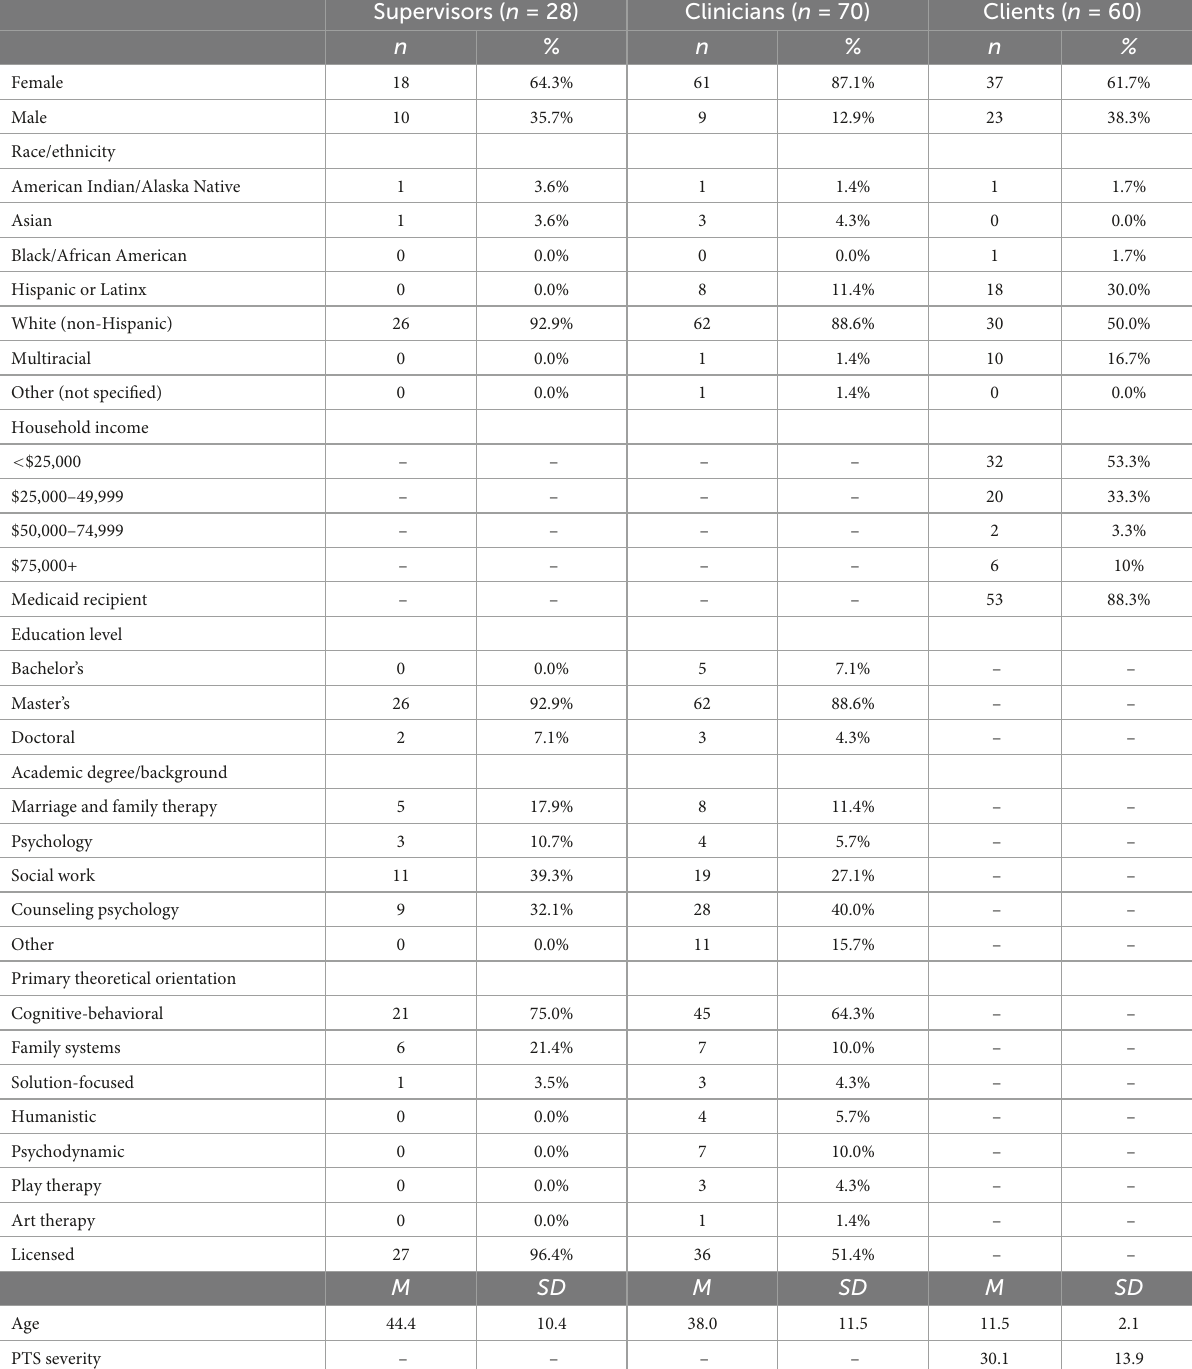
TABLE 4 Participant demographic and baseline